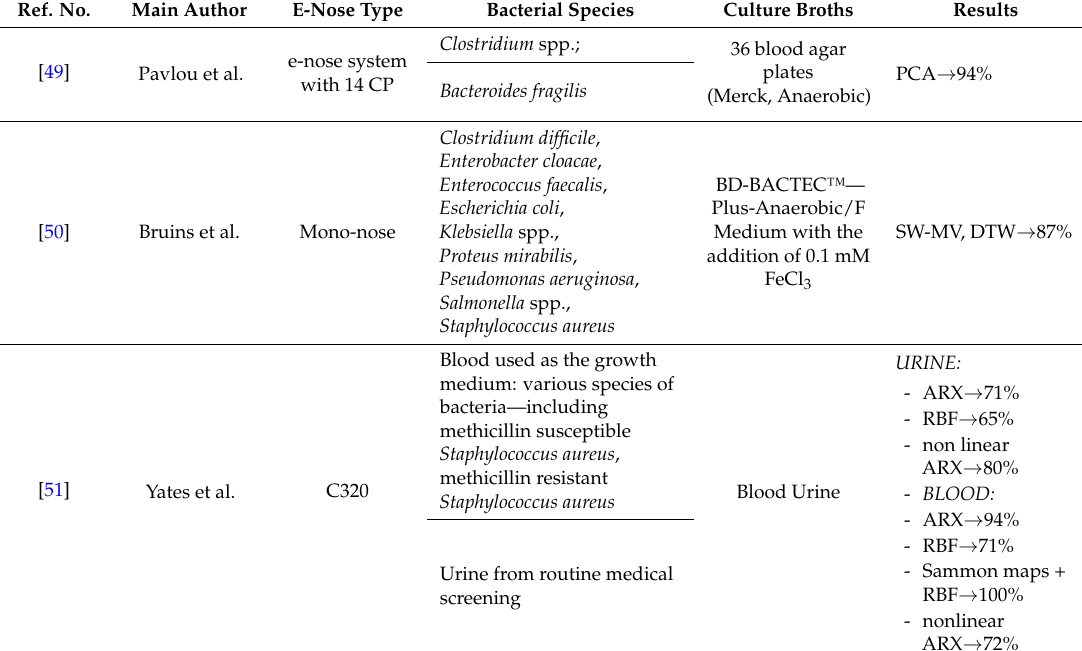
Table 2. Scheme of the studies regarding the detection/identification of bacteria cultures. Ref.